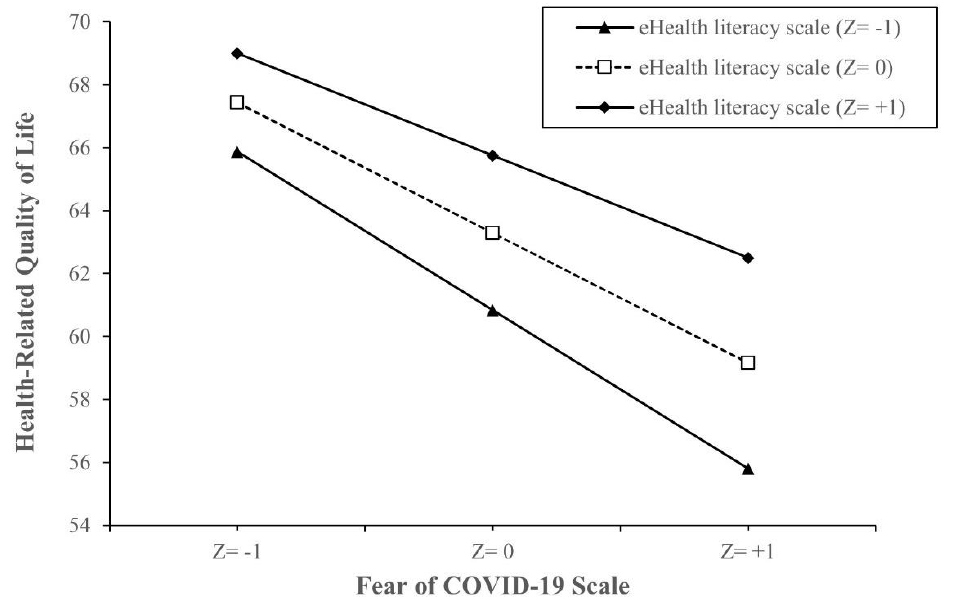
Figure 1. Simple slope plot of interaction between eHealth literacy and fear of COVID-19 on health- related quality of life (N = 4348). Note: Z = − 1, one SD below the mean; Z = 0, the mean; Z = +1, 1 SD above the mean. Z-score is the number of SD above or below the mean. Abbreviations: SD, standard deviation.